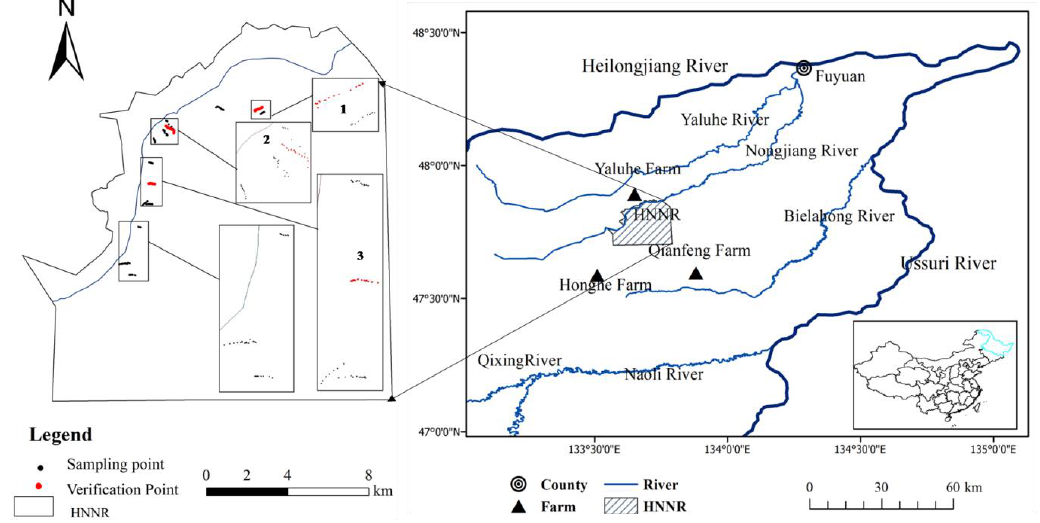
Figure 1. Location of the study area and distribution map of field sampling sites in the Honghe National Nature Reserve (HNNR).